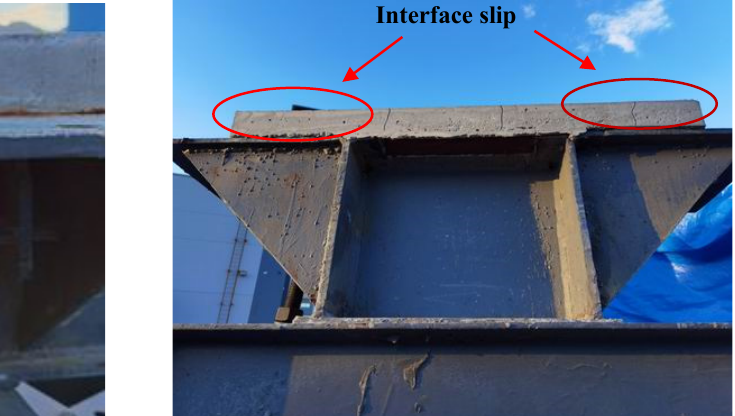
Figure 7. Crack profile of CCB-3. 3.2. Load–Displacement Curve and Capacity